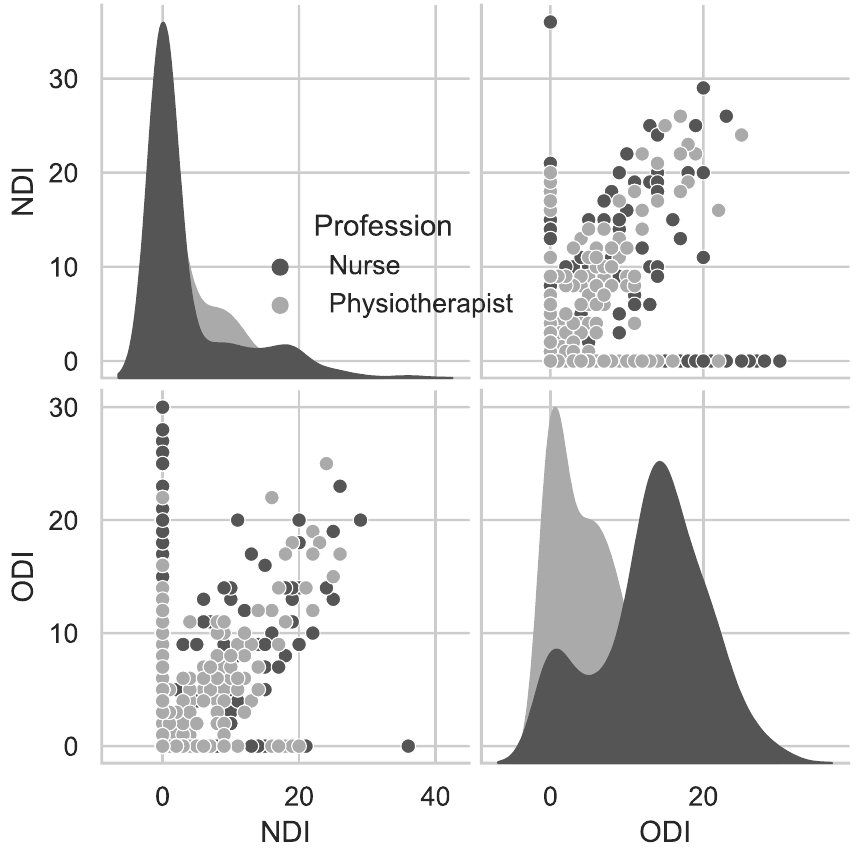
Figure 3. Pairwise relationship between NDI and